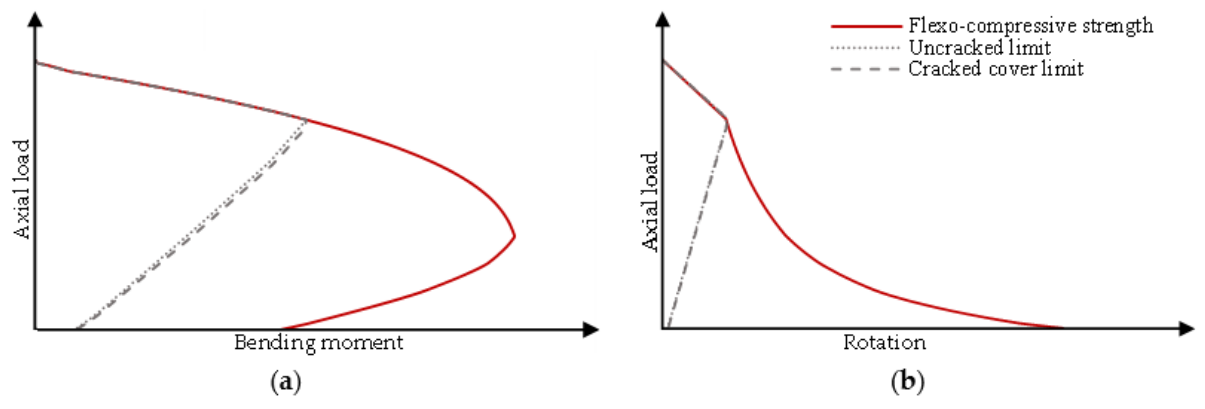
Figure 2. Flexo ‐ compressive strength: ( a ) Axial load—bending moment diagram; ( b ) Axial load—rotation diagram.